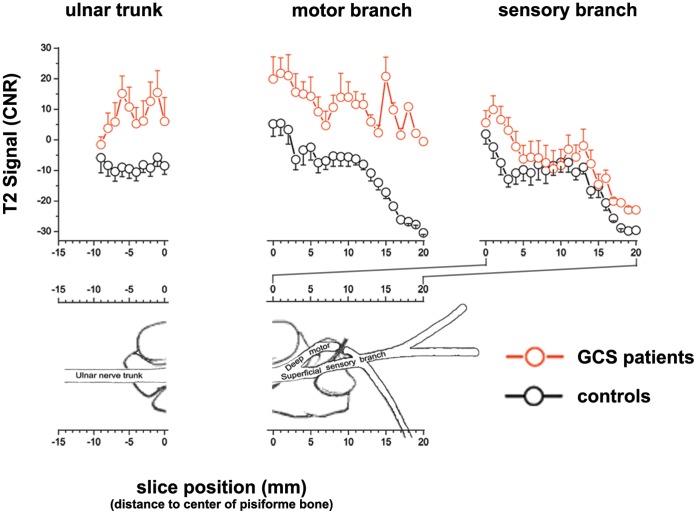
Proximal-to-distal mapping of nerve T2-signal.Mean T2-weighted CNR values and corresponding SEM (error bars) for the ulnar nerve trunk (left), the deep motor (middle) and the superficial sensory (right) branches. Graphs are plotted separately for GCS patients (red lines and dots) and asymptomatic controls (black lines and dots). Note the strong, statistically significant difference (p = 0.001) of increased T2-signal within the deep motor branch just distal to the osseus center of the pisiform bone for GCS patients as compared to healthy controls. T2-signal of the ulnar trunk more than the sensory branch was increased likewise compared to controls but without statistical significance. Median nerve T2-signal within each subject was not any different from ulnar nerve T2-signal (given in text of results section, not shown here). On the lower half of this graph array, an anatomical schematic drawing (according to Shea and McClain, 1969, with permission from The Journal of Bone and Joint Surgery, Volume 51, pages 1095–1103) is supposed to indicate the anatomical position of each slice with reference to the osseous center of the pisiform bone (slice position  = 0) as anatomical landmark. Slices proximal to center were assigned negative numbers indicating the distance (in mm) to center, slices distal to center were assigned positive numbers.